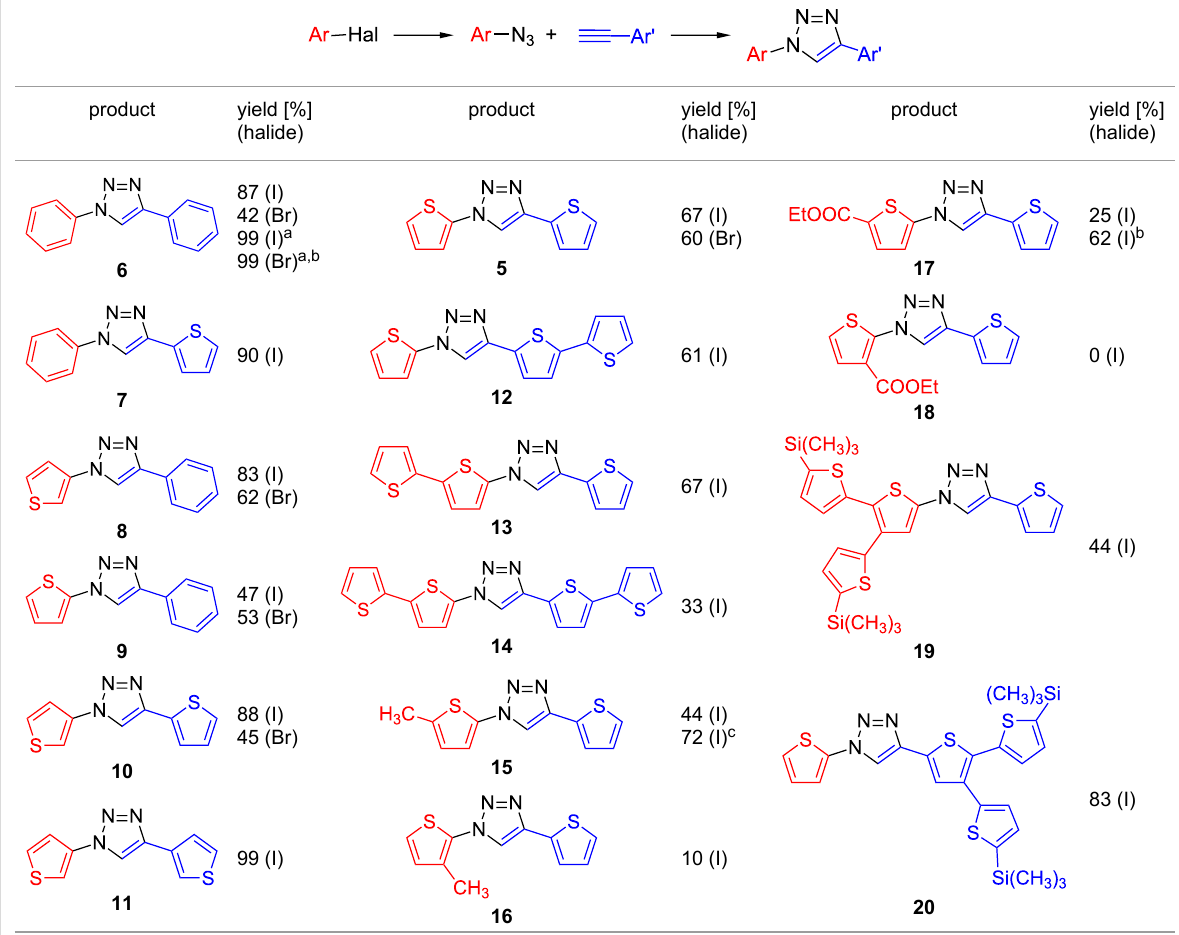
Table 2: Synthesis of 1,4-disubstituted 1,2,3-triazoles from corresponding halides (1 equiv), terminal acetylenes (1 equiv) and sodium azide (2 equiv) in the presence of copper(I) iodide (10 mol %), sodium ascorbate (10 mol %) and N , N ’-dimethylethylenediamine (DMEDA, 20 mol %) in ethanol–water (7:3) at 50 °C for 15 h. The yields are for pure compounds and are averages of two